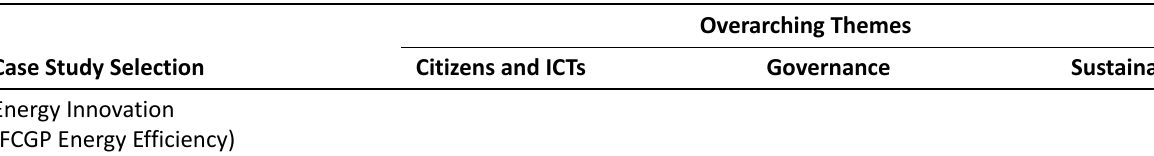
Table 2. Case study framework of analysis.